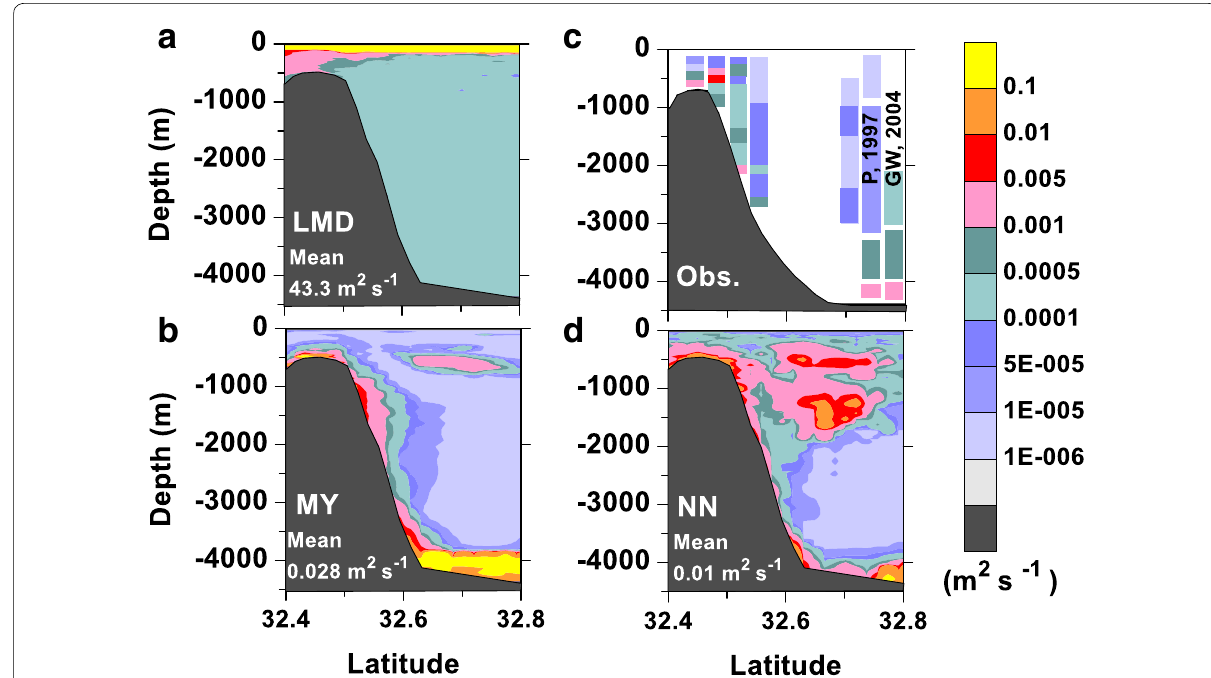
Fig. 6 A transect of the significant vertical temperature diffusivities at 128 o 41.0 ′ W for different vertical mixing parameterizations: a LMD, b MY, and d NN. c Observations from Kunze and Toole (1997) and Toole et al. (1997). In c , GW, 2004 refers to the values of Ganachaud and Wunsch (2004) and P, 1997 the observations of Polzin et al.